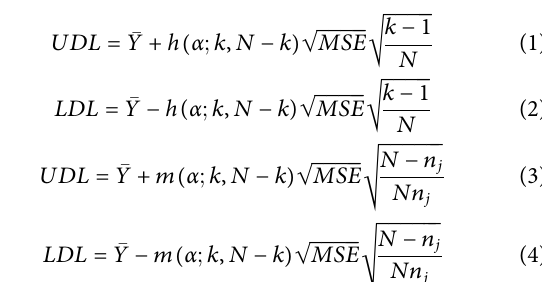
SOD (U/L) Mean ± Std. Dev